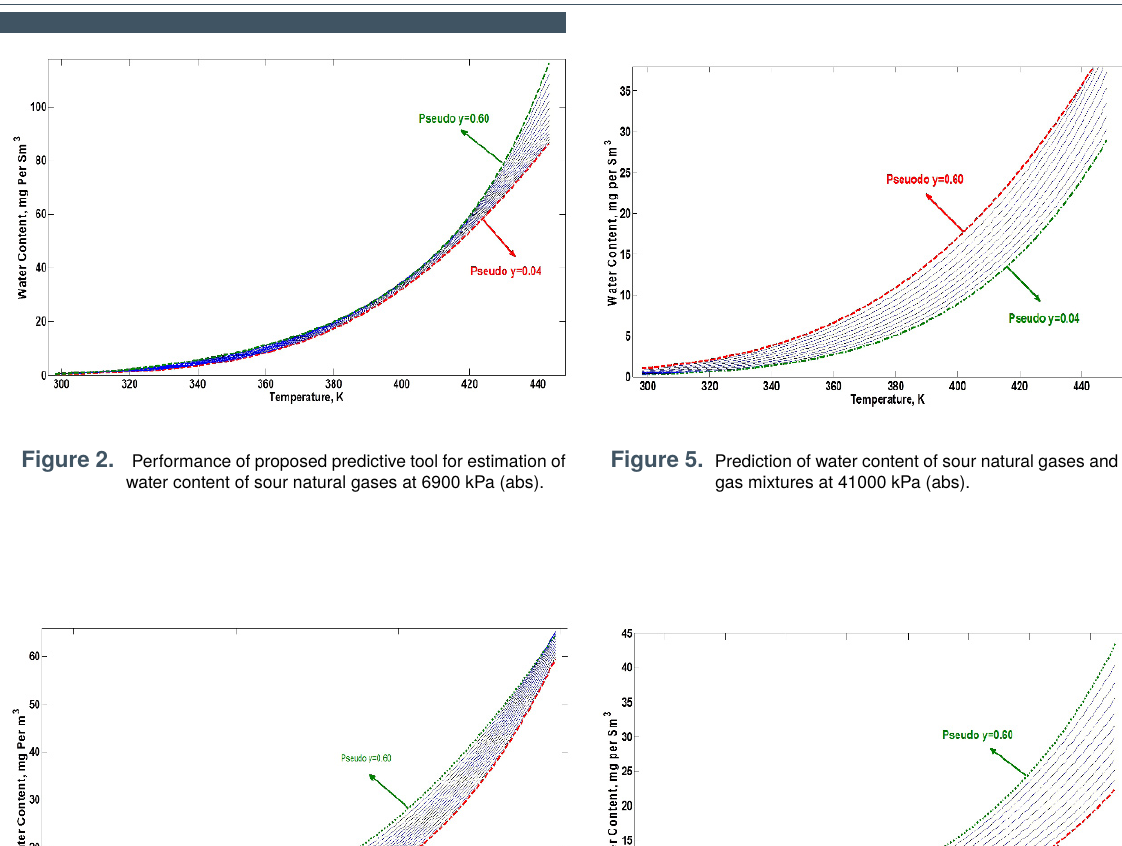
Figure 6. Prediction of water content of sour natural gases and acid gas mixtures at 69000 kPa